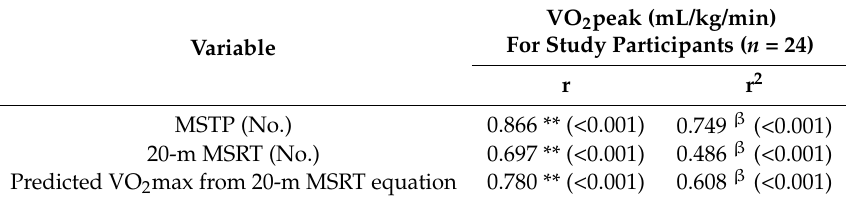
Table 3. Pearson’s correlations (r) and regression coefficients (r 2 ) between VO 2 peak (mL/kg/min) and alternative field tests for cardiorespiratory